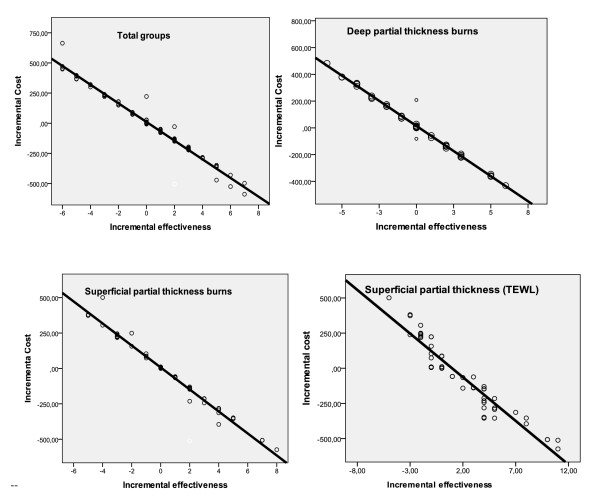
Scatter plots of Incremental costs and effectiveness for total groups, groups with deep partial thickness burs and groups with superficial partial thickness burns.